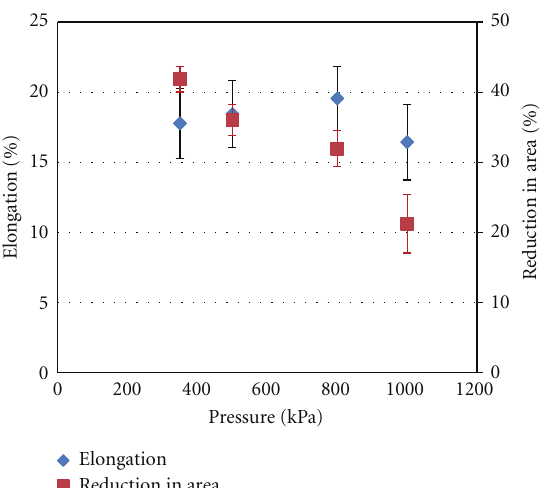
Figure 5: Reduction in area and elongation as a function of pressure of slow strain-rate tests performed at 20 ◦ C with a gas mixture of 25% CO and 75% CO 2 .